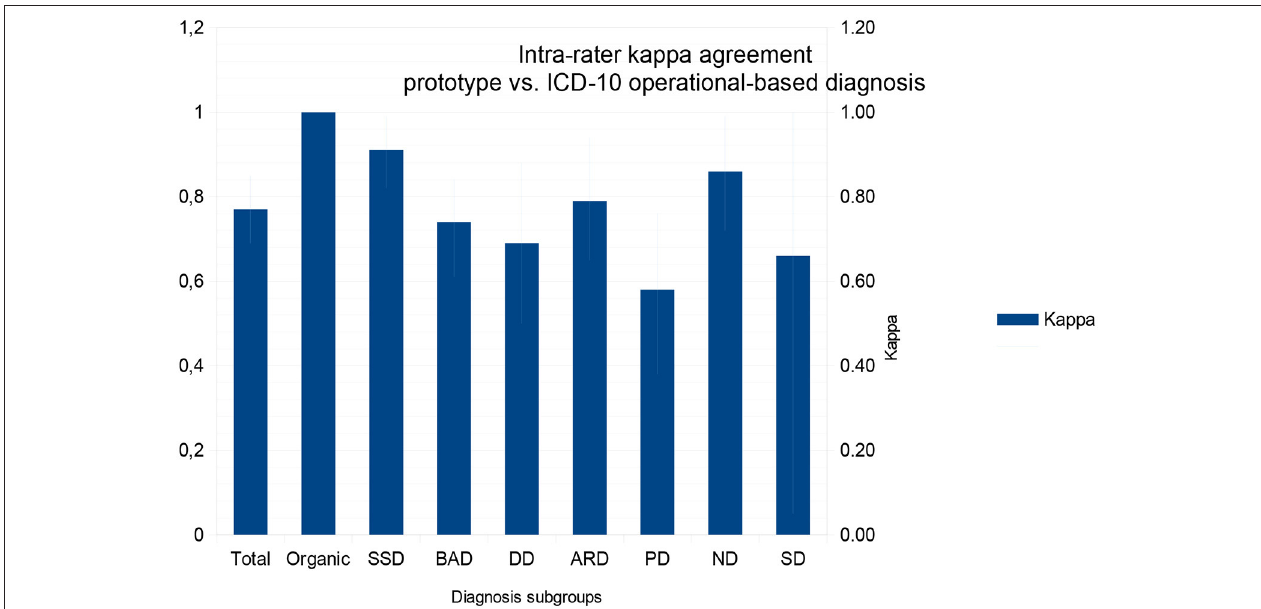
FIGURE 1 | Kappa values between operational and prototype diagnostics for each diagnostic subgroup and for the total comparisons. Values range from 0 (random agreement) to 1 (perfect agreement), and standard deviation is represented in light blue. ARD, Anxiety Related Disorders; BAD, Bipolar Affect Disorder; DD, Depressive Disorder; SSD, Schizophrenia Spectrum Disorder; ND, Neurodevelopmental Disorder; Organic, Brain damage or degenerative related disorders; PD, Personality Disorders; SD, Substance related